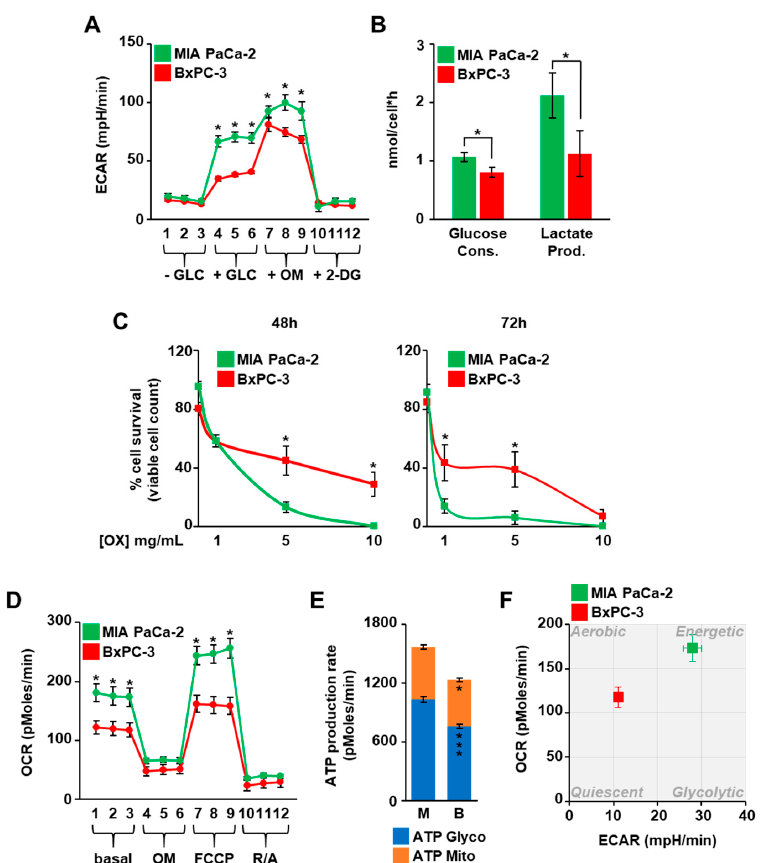
Figure 1. KRASmut MIA PaCa-2 cells are more glycolytic than KRASwt BxPC-3. ( A ) The extracellular acidification rate (ECAR) of MIA PaCa-2 and BxPC-3 cells throughout a glycotest assay was measured using the Seahorse XF24 Analyzer. ( B ) The glucose consumption and lactate production were calculated measuring the amount of glucose and lactate in cell media of MIA PaCa-2 and BxPC-3. ( C ) MIA PaCa-2 and BxPC-3 cells were cultured in presence of the glycolysis inhibitor oxamate (OX) and counted at the indicated time points using the Trypan Blue stain. ( D ) The oxygen consumption rate (OCR) of MIA PaCa-2 and BxPC-3 cells throughout a mitostress test was measured using Seahorse XF24 Analyzer. ( E ) The production rate of the ATP due to the glycolysis (ATP Glyco) and the mitochondrial respiration (ATP Mito) was evaluated in MIA PaCa-2 and BxPC-3 cells by performing the specific assay with the Seahorse XFe96 Analyzer. ( F ) The XF En- ergy Map was determined using the Seahorse profiles. All data represent the mean ± SEM of at least three independent experiments. * p < 0.05, *** p < 0.001 (Student’s t-test), MIA PaCa-2 vs. BxPC-3.